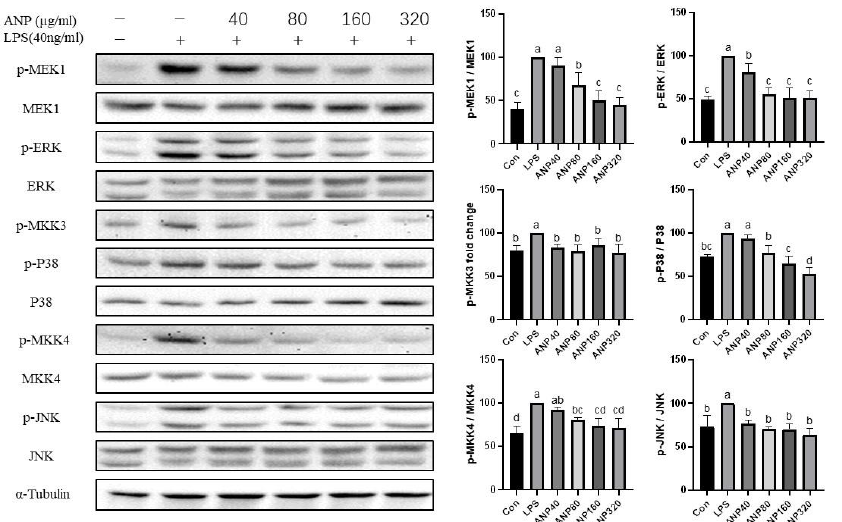
Figure 8. ANP inhibited the phosphorylation of MEK1, ERK, MKK3, p38, MKK4, and JNK induced by LPS. Left pictures are western blots of indicated proteins and α -tubulin as a control. Right pictures are the density histogram of western blots. The “ p -” means “phosphorylated”. The results shown are presented as means ± SD ( n = 3). The different letters in the graph indicate significance ( p < 0.05).